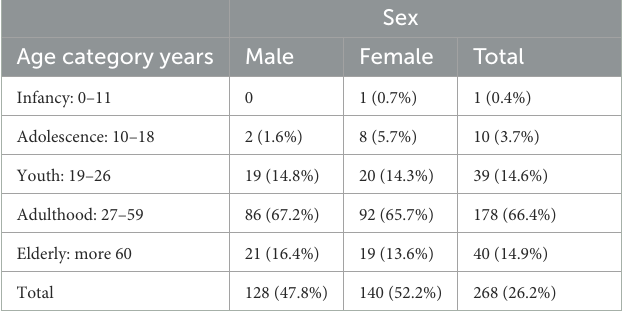
TABLE 1 SARS-CoV-2 infection rates (%) distribution according to sex and age.